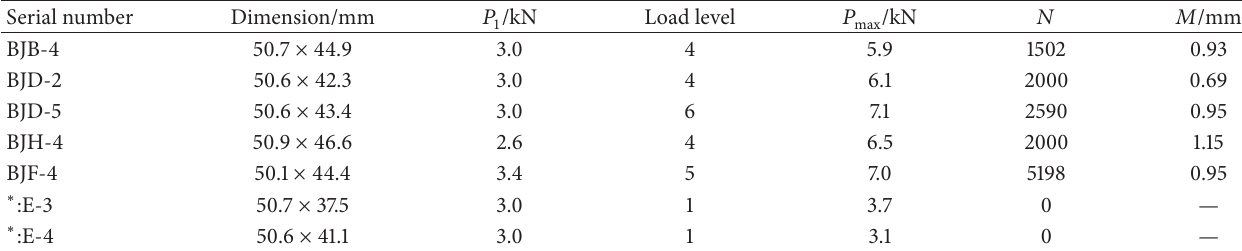
Table 2: Brazilian split fatigue test results of rock salt.